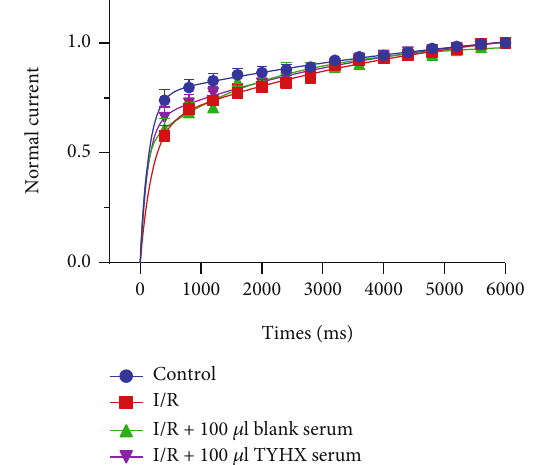
Figure 8: The e ff ect of TYHX on the recovery from the inactivation of I Kur